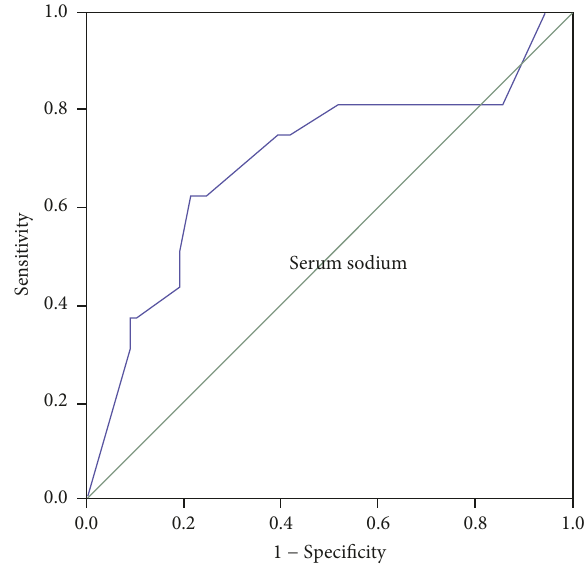
Figure 1: Receiver operator characteristic (ROC) curve for serum sodium in cirrhotic patients tested for adrenal insufficiency.